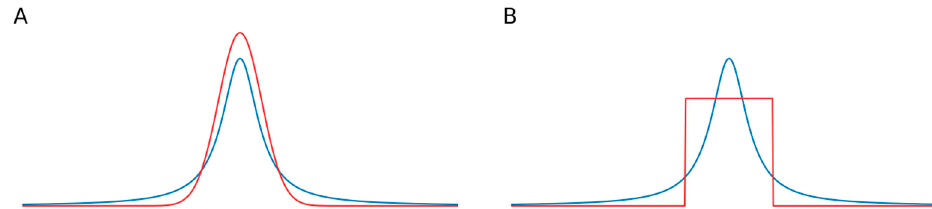
Figure A2. Theoretical probability distributions. The blue curve is the t-distribution with one degree of freedom. ( A ) The normal distribution is in red. ( B ) The suggested distribution is in red. By ranking the distances d ij between examples, custom distributions based on the rank r ij can be constructed. A simple alternative is to assume that each example has a certain number n ≥ 1 of close neighbors, and that all other examples are distant. Thus, by setting the n lowest ranked distances d ij to a value of a and the rest to a value of b (cid:28) a , and then normalizing with the sum c of all values, this results in a probability distribution with probabilities (Figure